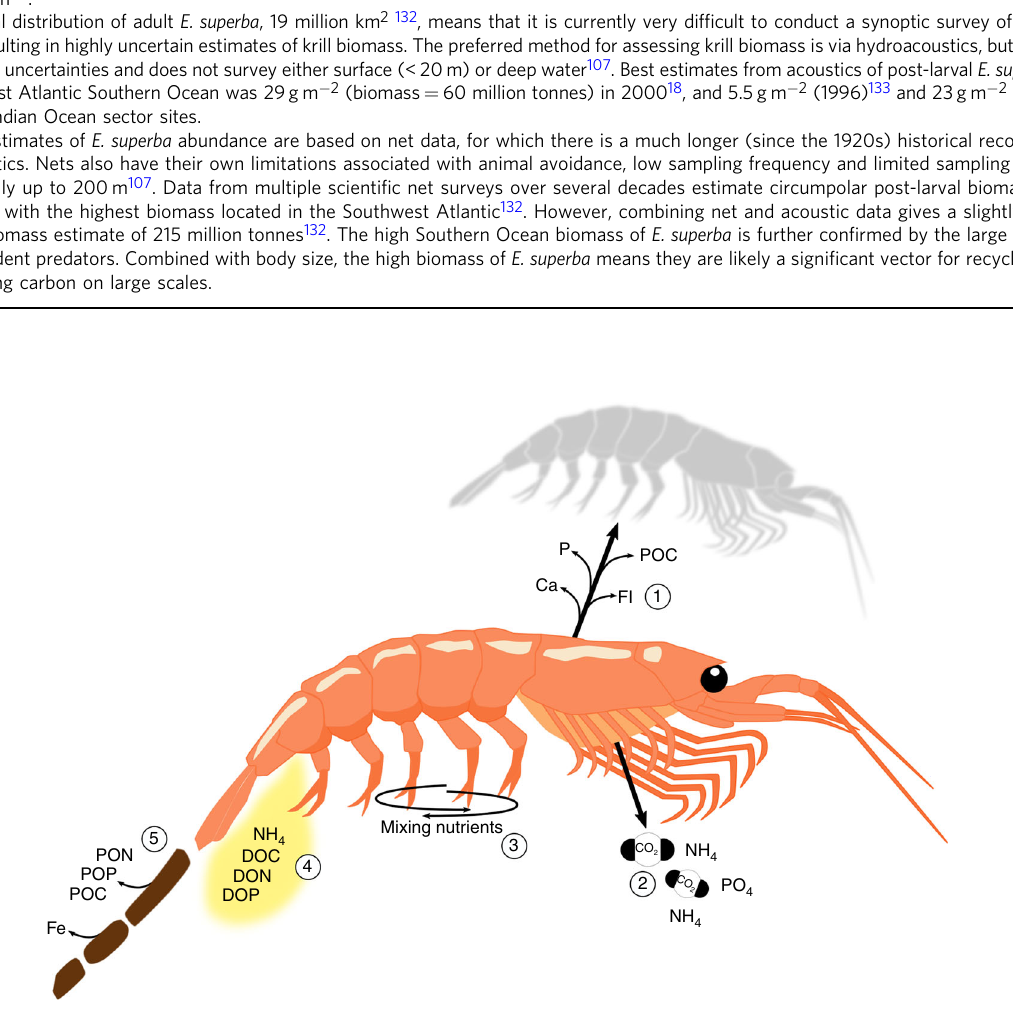
Fig. 2 Cycling of nutrients by an individual krill. When krill moult they release dissolved calcium, fl uoride and phosphorous from the exoskeleton (1). The chitin (organic material) that forms the exoskeleton contributes to organic particle fl ux sinking to the deep ocean. Krill respire a portion of the energy derived from consuming phytoplankton or other animals as carbon dioxide (2), when swimming from mid/deep waters to the surface in large swarms